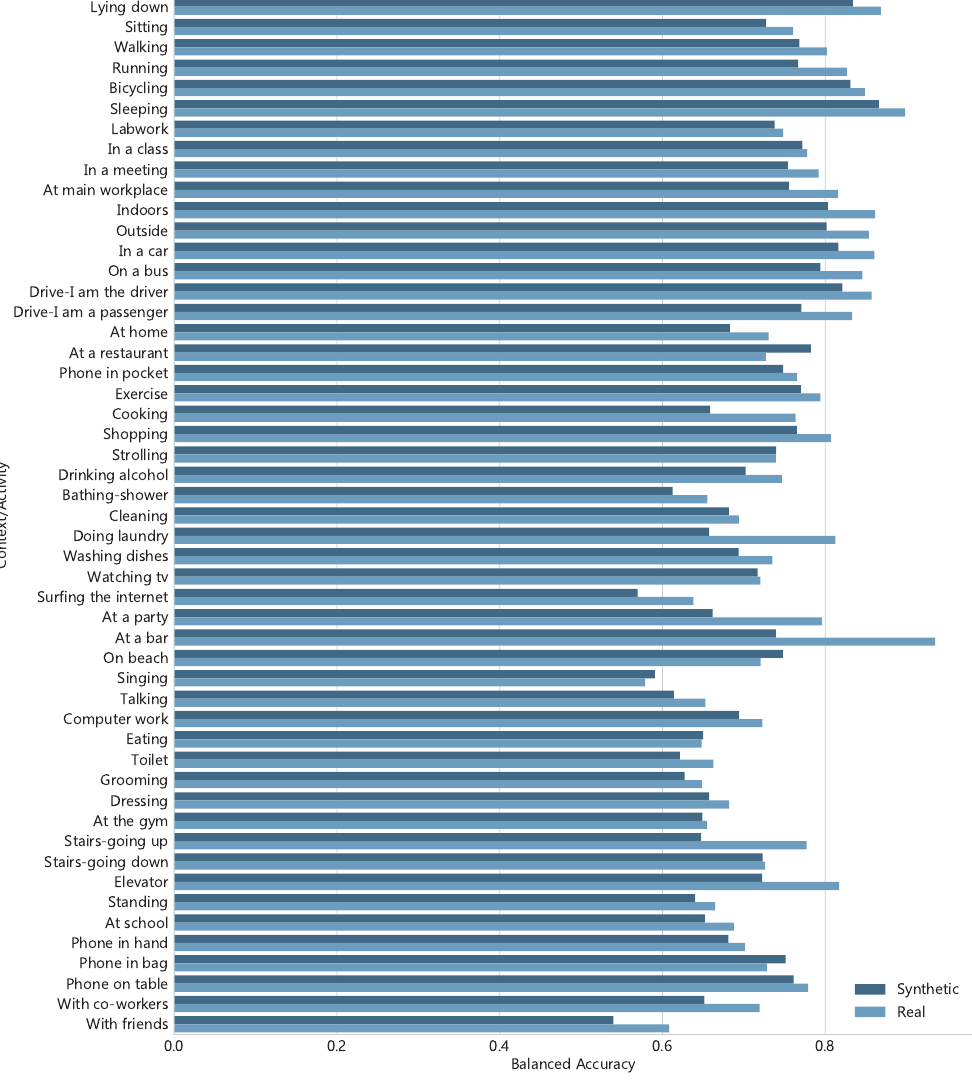
Figure 12. Obtained balanced accuracy of 51 contextual labels for two classifiers trained with real and synthetic samples–evaluation is done on real test data with 5-folds